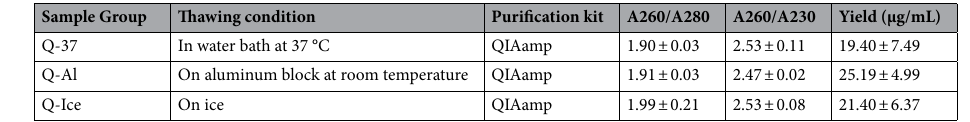
Table 2. Yield and quality of DNA extracted from peripheral whole blood samples using different conditions after short-term storage. Data are shown as mean ± standard deviation (n = 6). A 260/280 absorbance ratio at 260 and 280 nm, A 260/230 absorbance ratio at 260 and 230 nm.